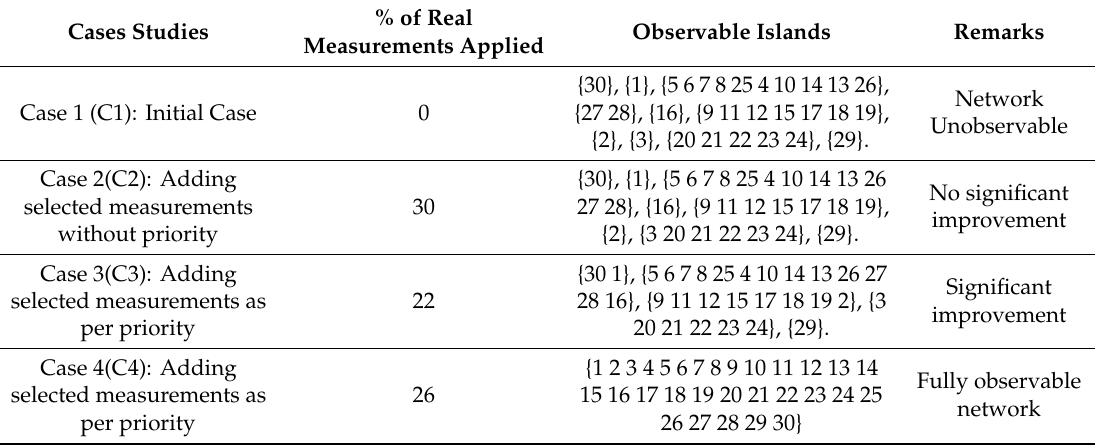
Table 1. Observability assessment